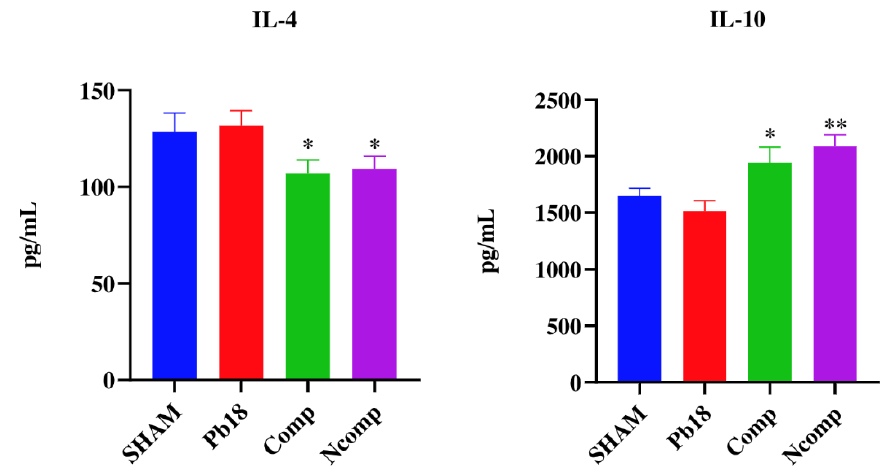
Figure 7. Th2 cytokine production 51 days post infection. IL-4 was significantly decreased, and the IL-10 was significantly increased, for both nanoparticles treated groups when compared to the Pb18 group. SHAM (non-infected and non-treated), Pb18 (infected and non-treated), Comp (infected and treated with the P10 complexed nanoparticles) and Ncomp (infected and treated with the P10 co-administered with empty nanoparticles). * = p < 0.05 and ** = p < 0.01.